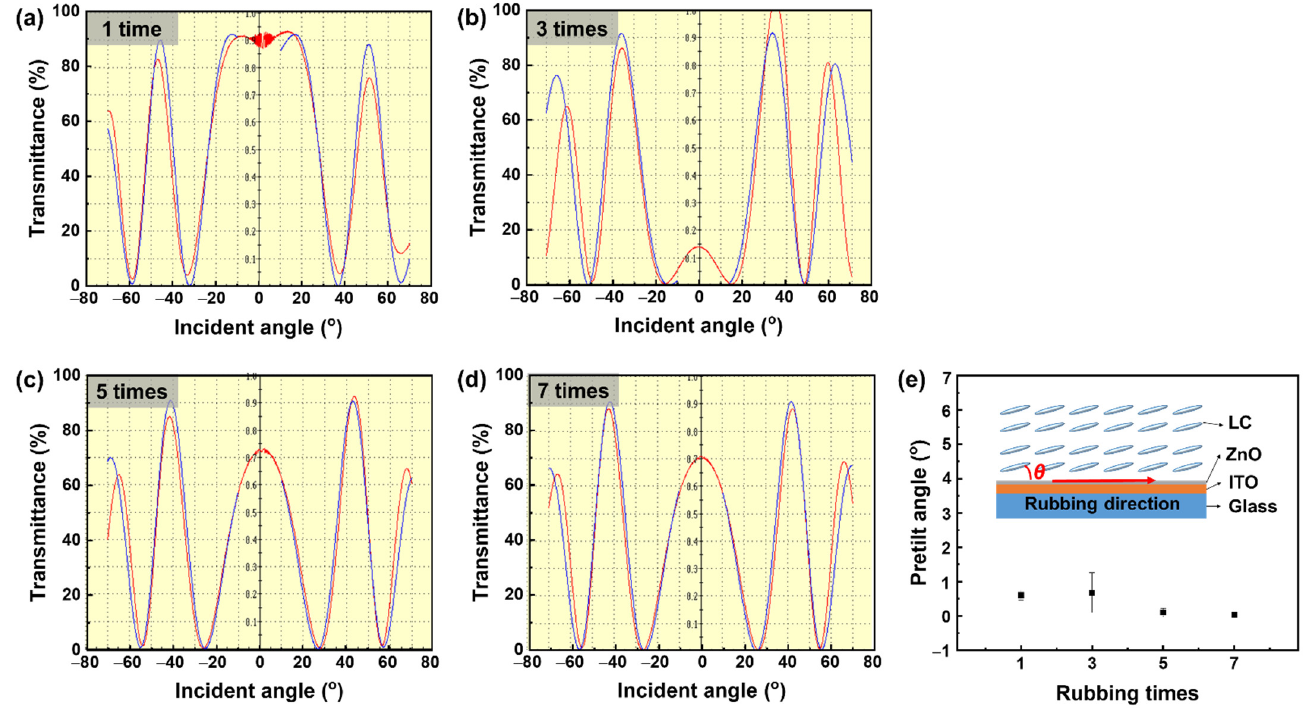
Figure 3. ( a – d ) Pretilt angles of LC molecules on solution-derived ZnO films in AP LC cells as a function of rubbing iteration number and ( e ) calculated pretilt angles of the LC molecules.